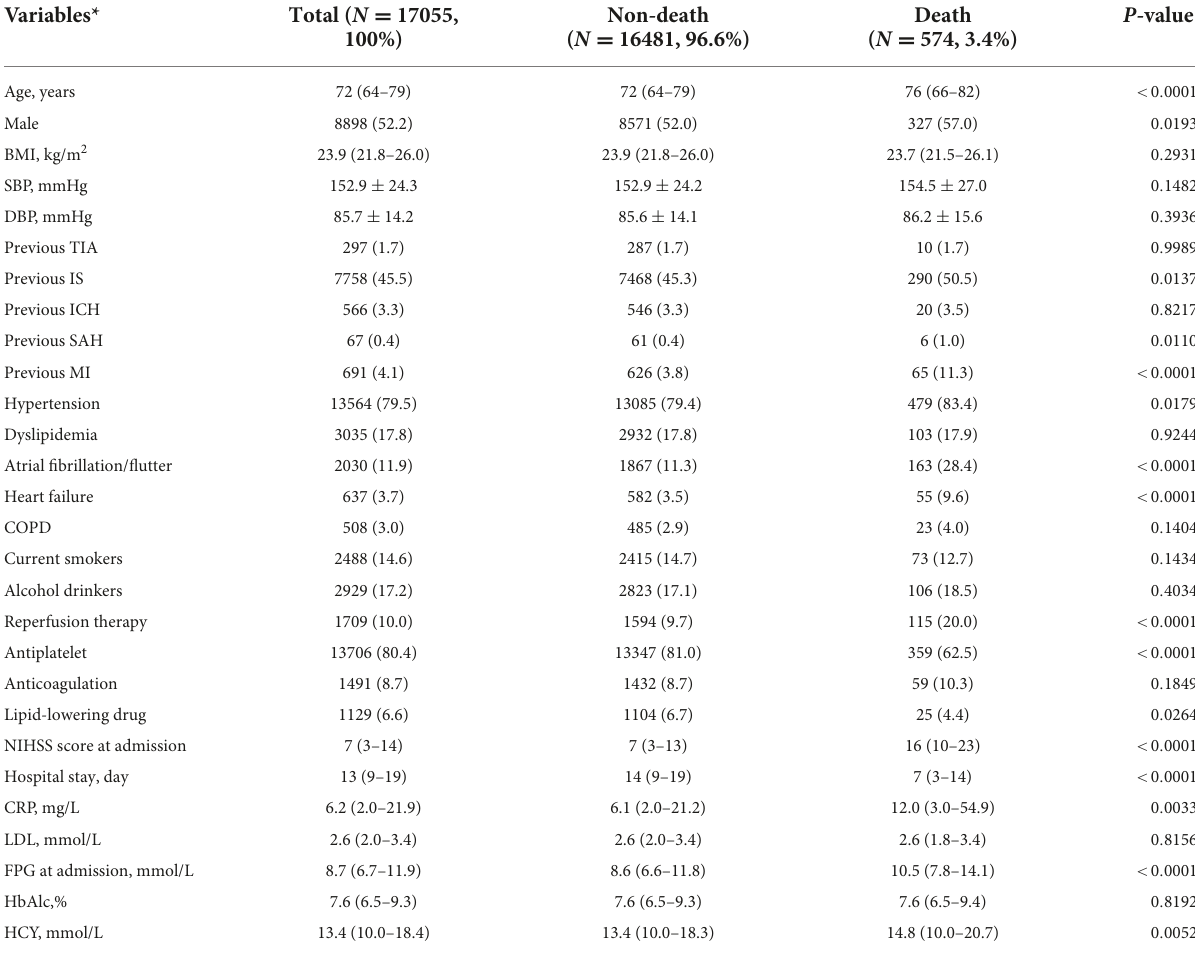
TABLE 3 Demographic and clinical characteristics of infected